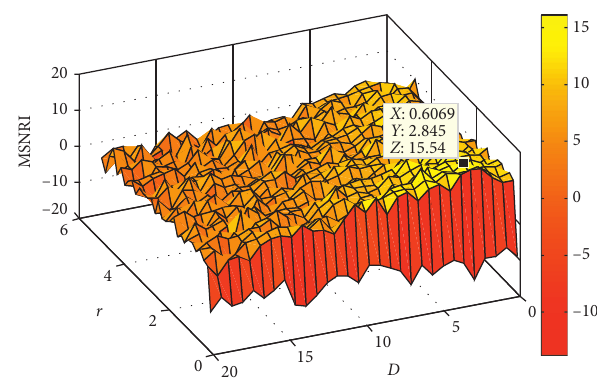
Figure 6: Three-dimensional graph of MSNRI varying with D and R .